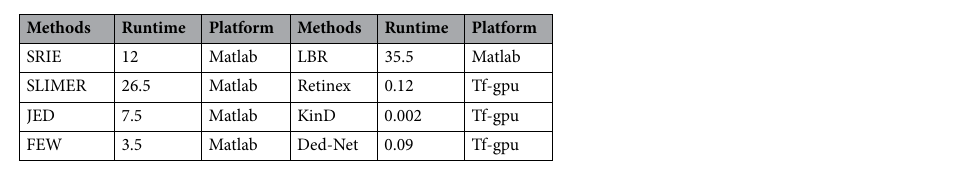
Table 3. Runtime comparison of various methods.